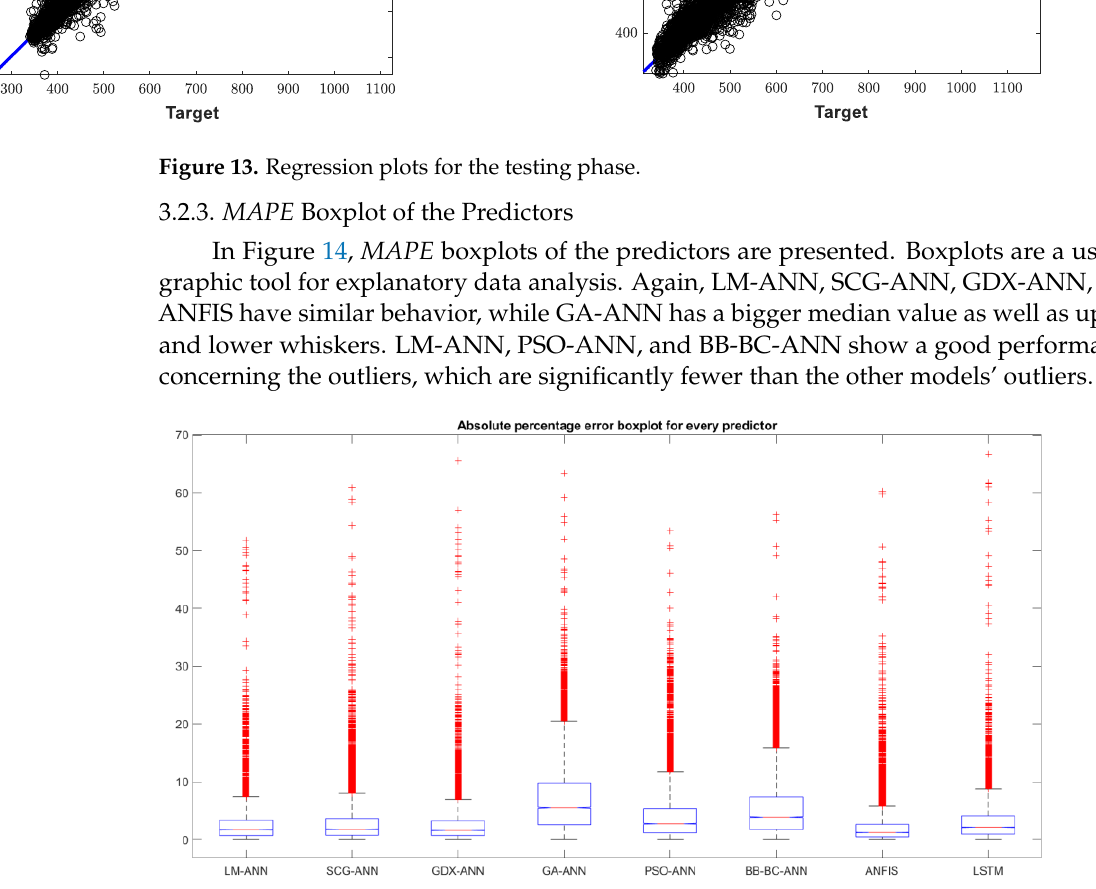
Figure 14. Boxplot for MAPE of the test sets.